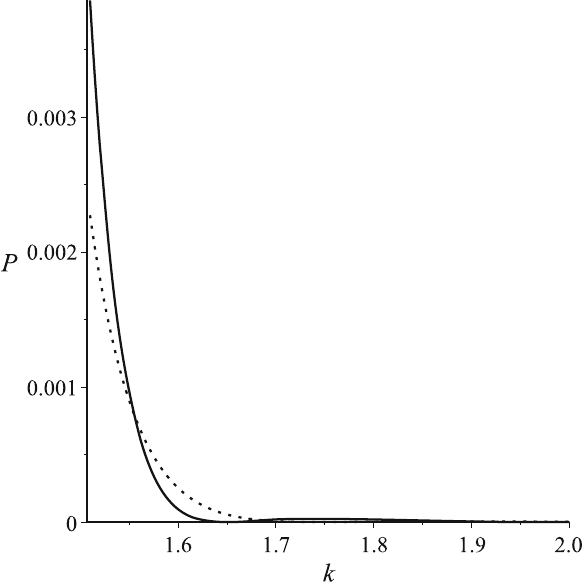
Fig. 1 P as a function of k for p / p (cid:8) = 0 . 9 solid line and p / p (cid:8) = 0 . 8 the point line. Angle β − ϕ = 0